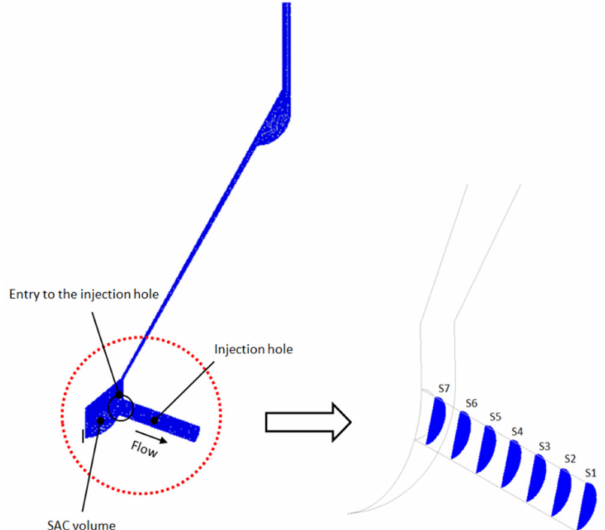
Figure 7. Schematic presentation of injection hole, nozzle SAC volume and location (slices) for presentation of results inside the injection